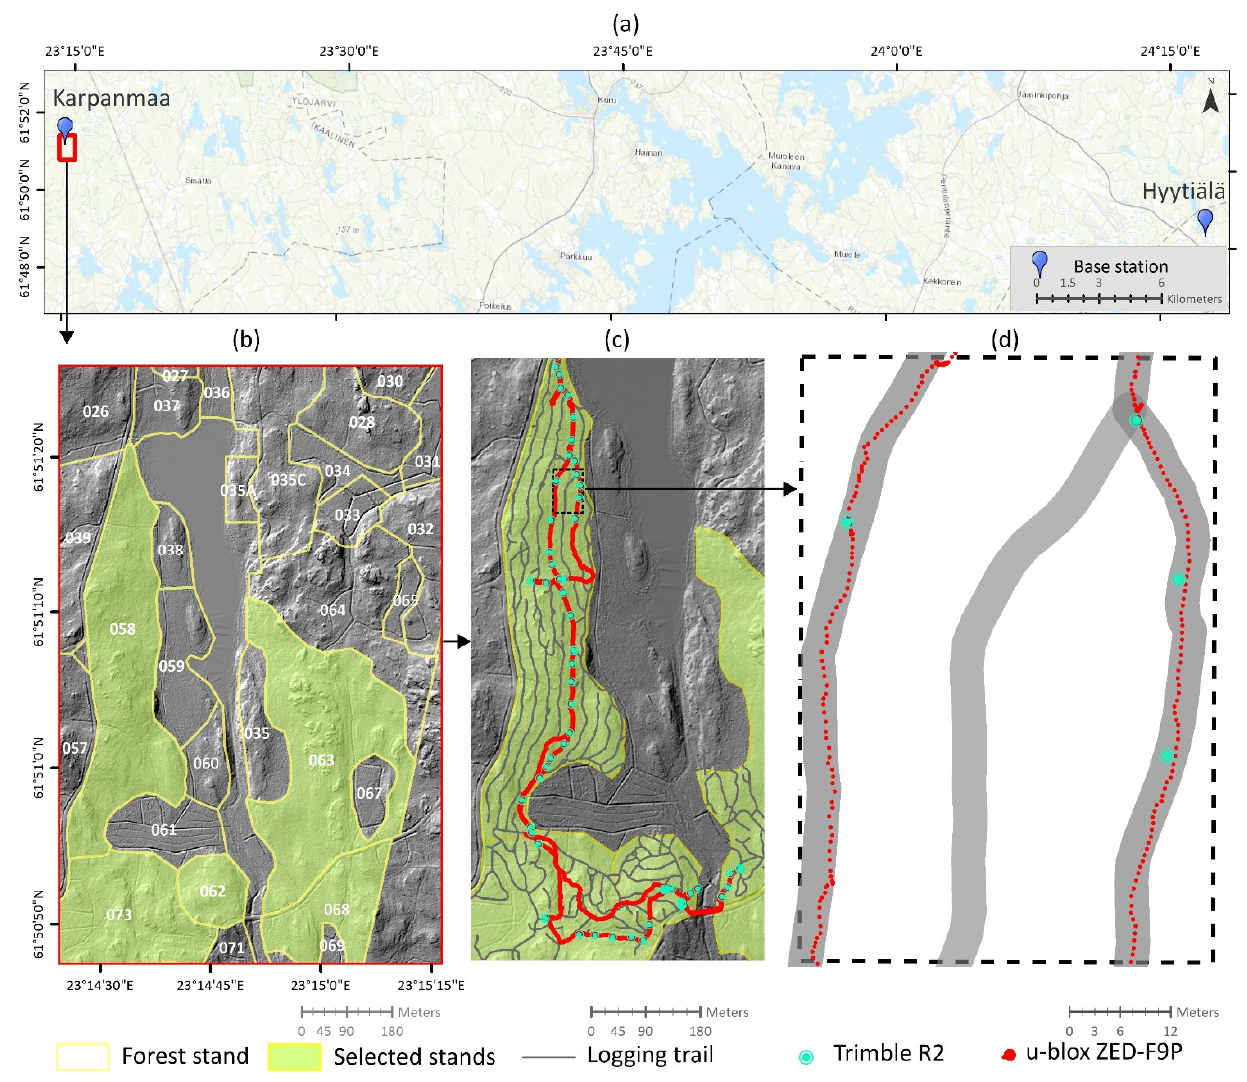
Figure 1. The study site and field measurements in southern Finland: ( a ) the locations of base stations and study area, ( b ) selected stands in Karpanmaa site, ( c ) logging trails, measured positions using the Trimble R2 and u-blox ZED-F9P and ( d ) the patterns of the recorded positions by u-blox ZED-F9P on the logging trails within an example of the study stands.